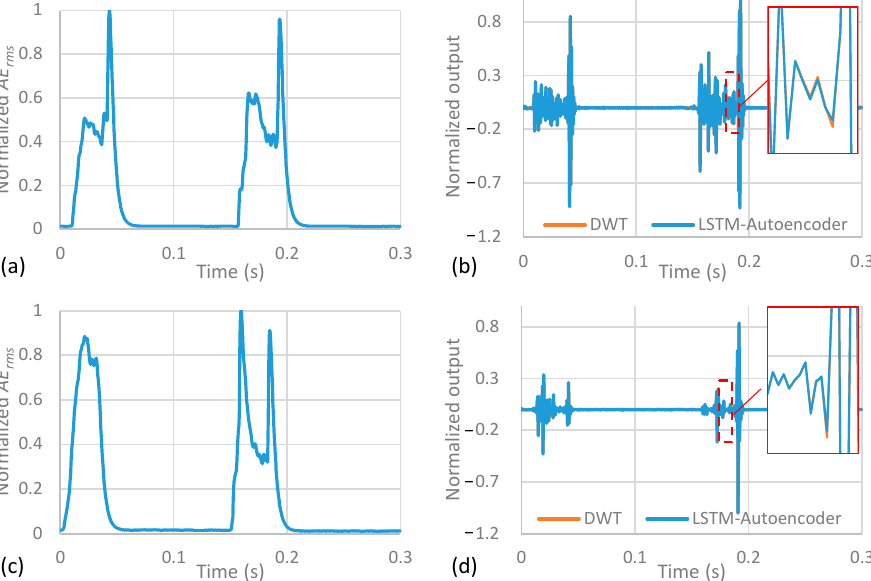
−−− Figure 3. ( a , c ) Normalized AE rms signals and ( b , d ) the DWT output and its reconstructed representation from the LSTM Autoencoder of Tests number 1 and 3, respectively.